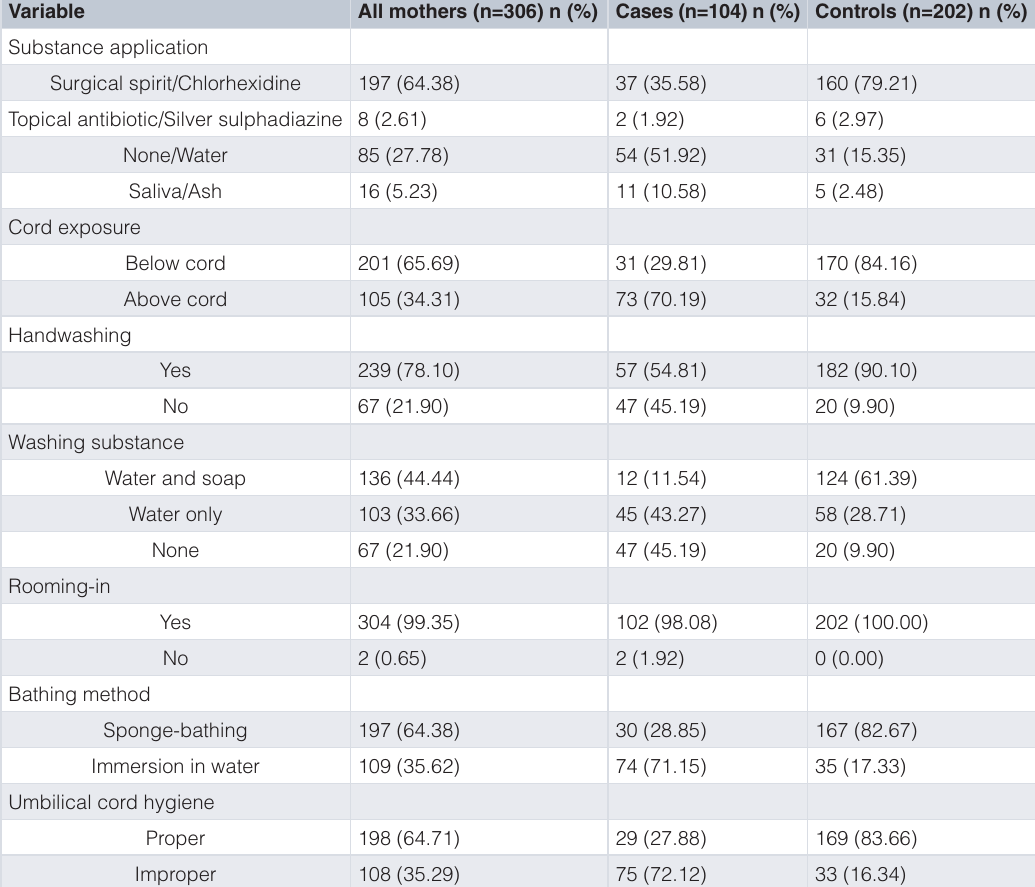
Table 3. Cord care practices and cord hygiene among mothers/primary care-givers, KHC, Kenya, 2018 (n=306).